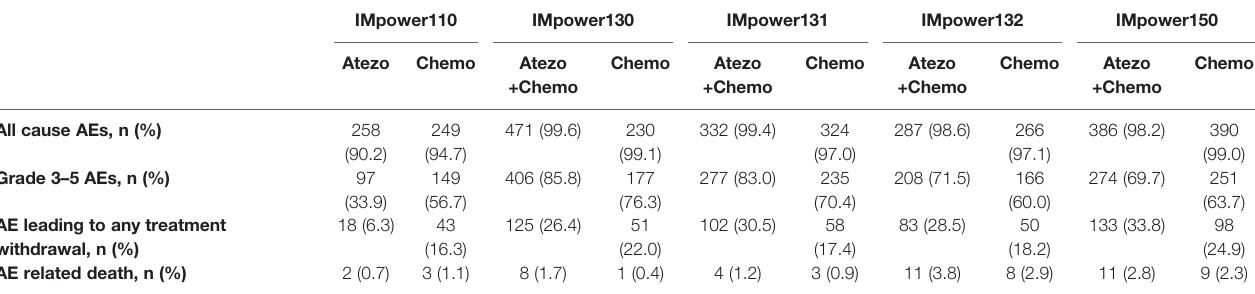
TABLE 2 | Safety summary.